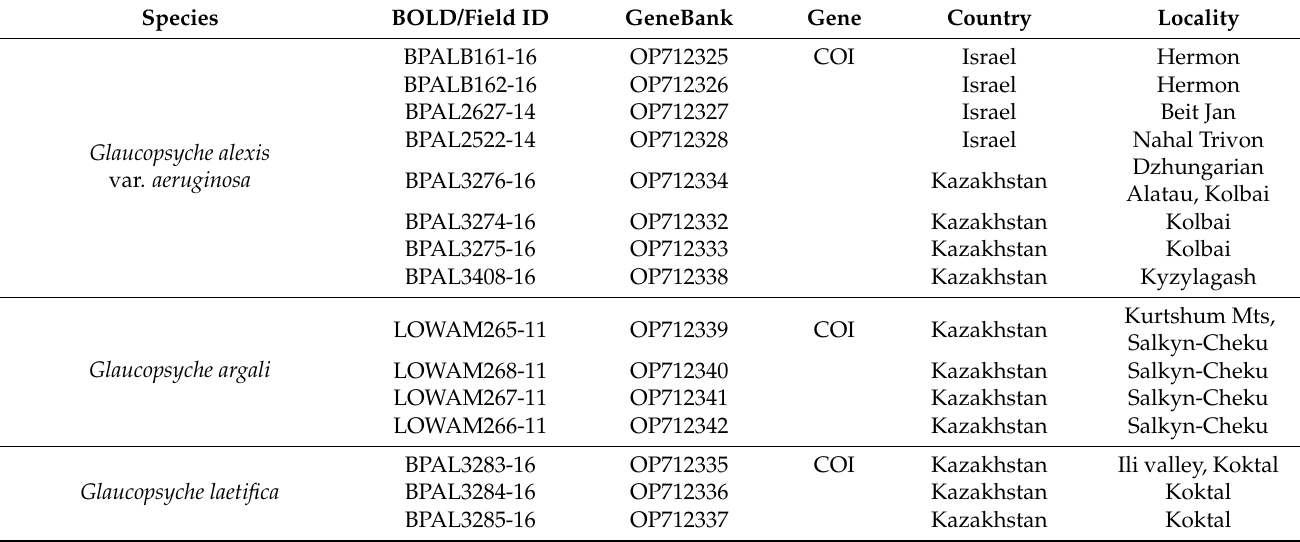
Table 1. List of the studied samples and obtained sequences. Species BOLD/Field ID GeneBank